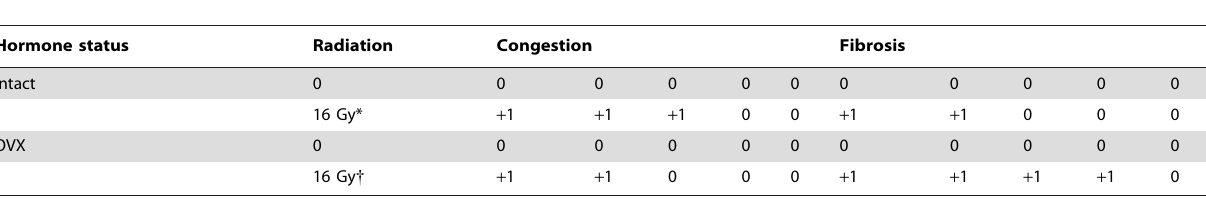
Table 5. Congestion and fibrosis in intact and ovariectomized (OVX) mice receiving either 0 or 16 Gy radiation 30 days previously.